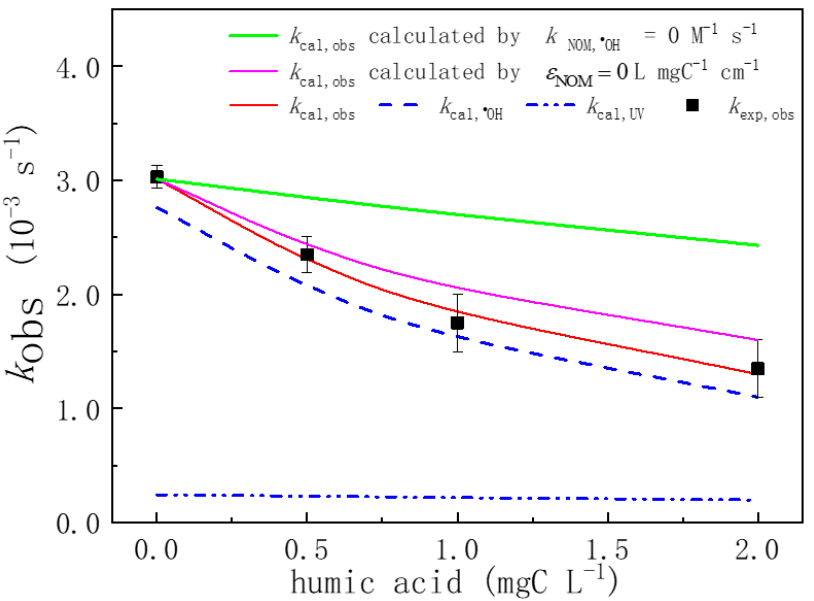
Figure 7. Impacts of humic acid on the pseudo first-order constants of MTZ ( k obs ). ([MTZ] 0 = 10 μM, [H 2 O 2 ] 0 = 100 μM, and I 0 = 7.50 × 10 − 6 Einstein L − 1 s − 1 , l = 0.935 cm). [H × 10 − 6 Einstein L − 1 s − 1 , l = 0.935 µ M, and I 2 O 2 ] 0 = 100 0 = 7.50